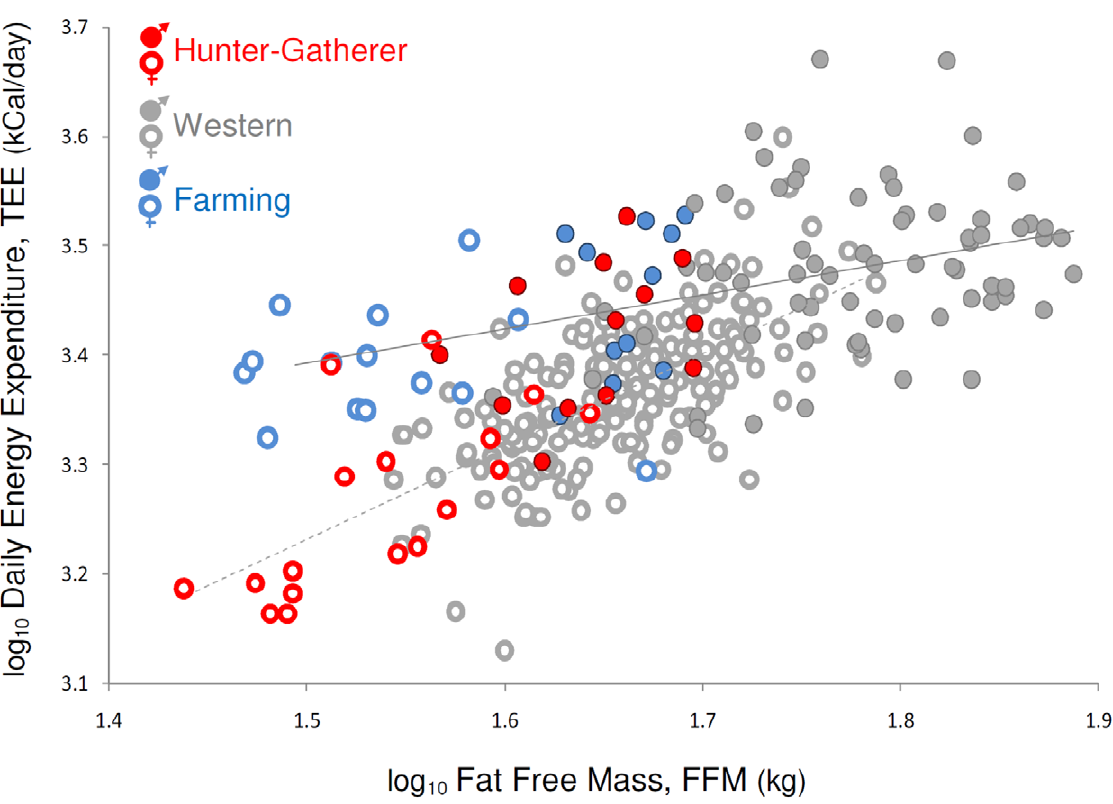
Figure 1. Individual comparisons of TEE and FFM. Energy expenditure for Hadza hunter-gatherers (red circles) was similar to that of Westerners (gray [19–26]). Bolivian women farmers (blue open circles [13,31]) had higher TEE than either Hadza or Western women. Trendlines are ordinary least squares regressions through Western men (solid line) and Western women (dashed line).